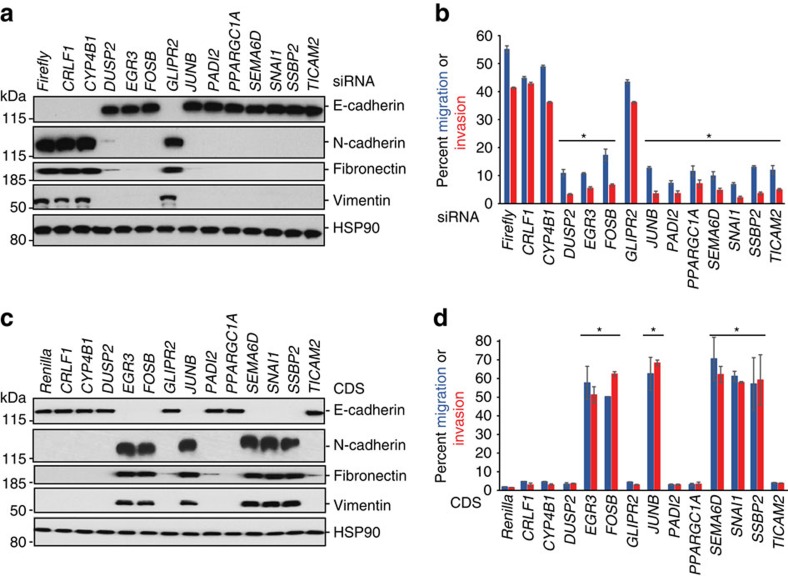
GREs encode gene products required for EMT.(a) Immunoblot analysis of epithelial and mesenchymal cell markers in TGF-β-treated MCF10A cells transiently transfected with siRNAs targeting Firefly Luciferase or the indicated mRNAs. HSP90 serves as a loading control. (b) Quantification of relative cellular migration and invasion in transwell assays in TGF-β-treated MCF10A cells transiently transfected with siRNAs targeting Firefly Luciferase or the indicated mRNAs. (c,d) As in a and b except that untreated MCF10A cells were stably transduced with pL6.3-Renilla Luciferase or pL6.3-driving the expression of the indicated coding sequences, respectively. All panels are representative of a minimum of three experimental replicates. For immunoblots depicted, samples were derived from the same experiment and gels were processed in parallel. Error bars depict s.d. of the mean. *P≤0.05 (Student's t-test). See also Supplementary Fig. 2. Full scans of blots are shown in Supplementary Fig. 9.